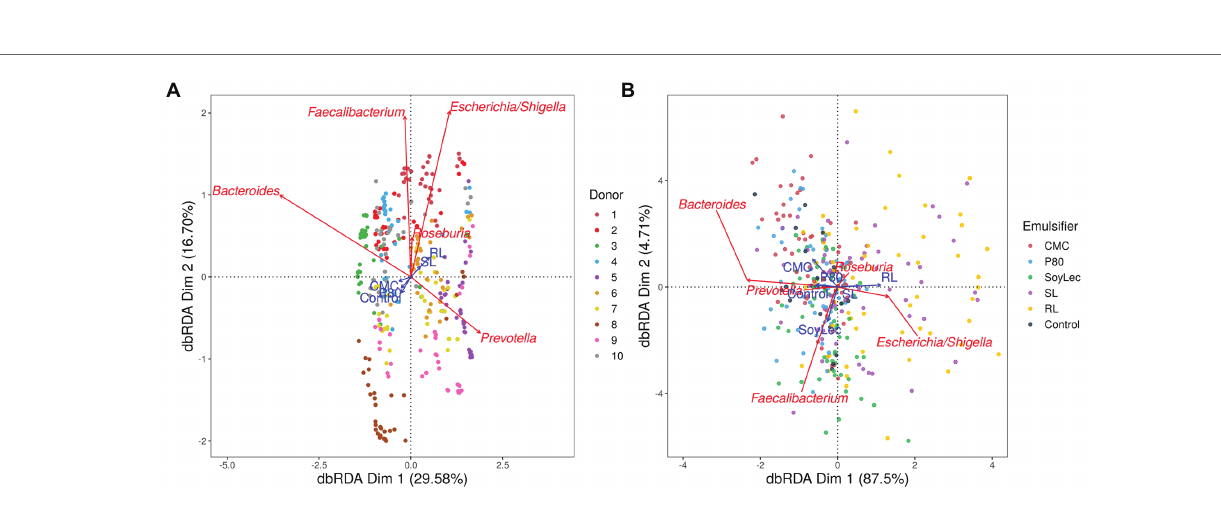
FIGURE 3 | Type II scaling triplots obtained using partial distance based redundancy analysis of the microbial community composition detected using 16S rRNA gene amplicon sequencing after 48 h of in vitro batch incubations of fecal material from 10 donors with sugar depleted medium supplemented with five emulsifiers at four concentrations. Samples were taken upon incubation (T0; 2–3 h after inoculation) as well as after 24 h (T1) and 48 h (T2) of incubation. Factors donor, emulsifier, and emulsifier concentration were set as explanatory variables (blue arrows) and absolute abundances of genera as response variables (red arrows). Only the top five genera were displayed for adequate visibility. Axes are annotated with their contribution to the total variance. (A) The factor timepoint was partialled out. (B) The factors donor and timepoint were partialled